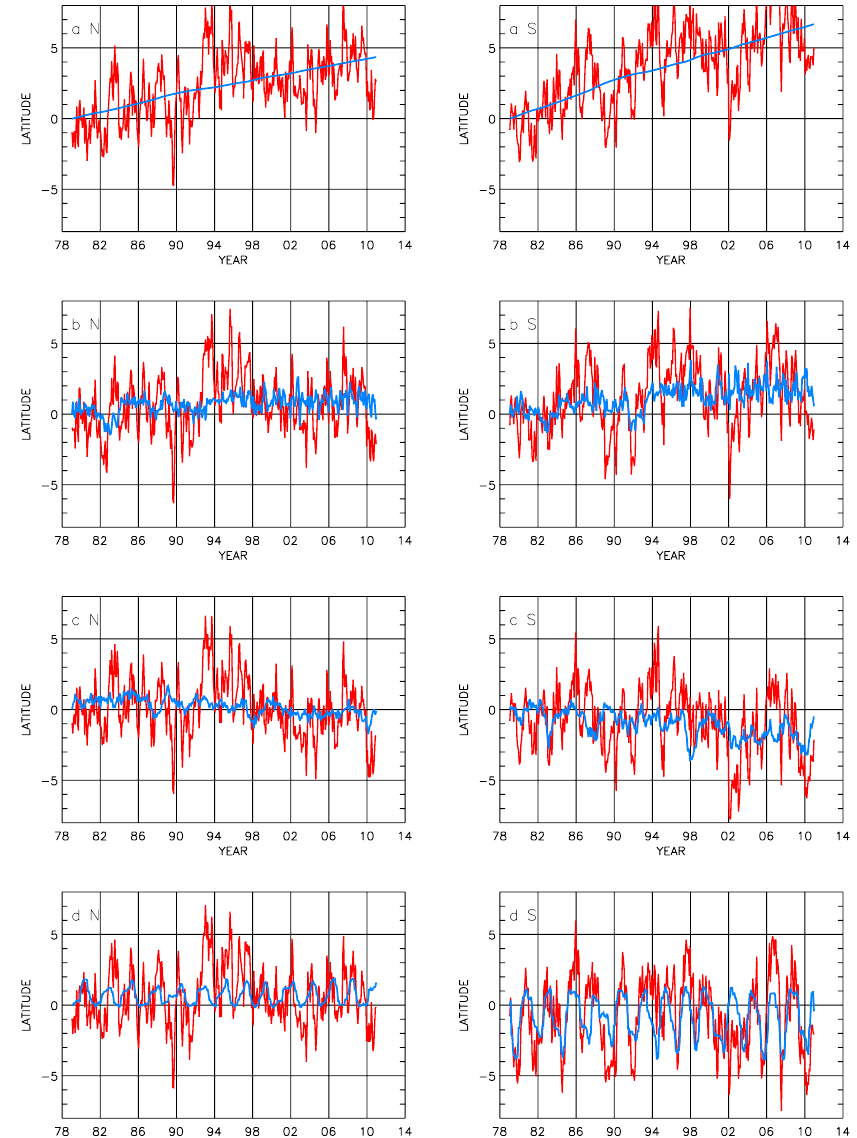
Fig. 6. Comparison between the best fit (blue line) for each climate index compared to the residual (red line) obtained from a regression analysis of the monthly mean equivalent latitude performed without that climate index: (a) (N and S) for RADF, (b) (N and S) for TEMP, (c) (N and S) for ERSST, and (d) (N snd S) for